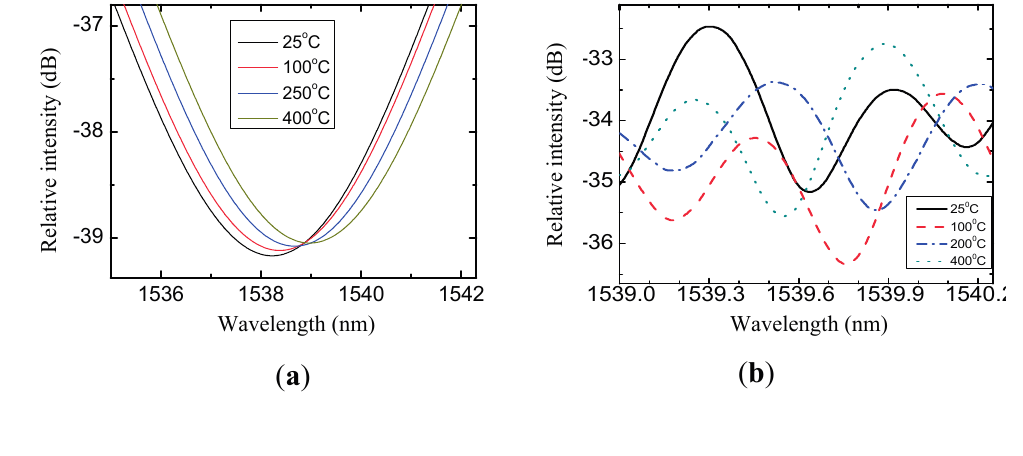
Figure 5. The spectrum shift of with temperature. ( a ) cavity 1 and ( b ) cavity